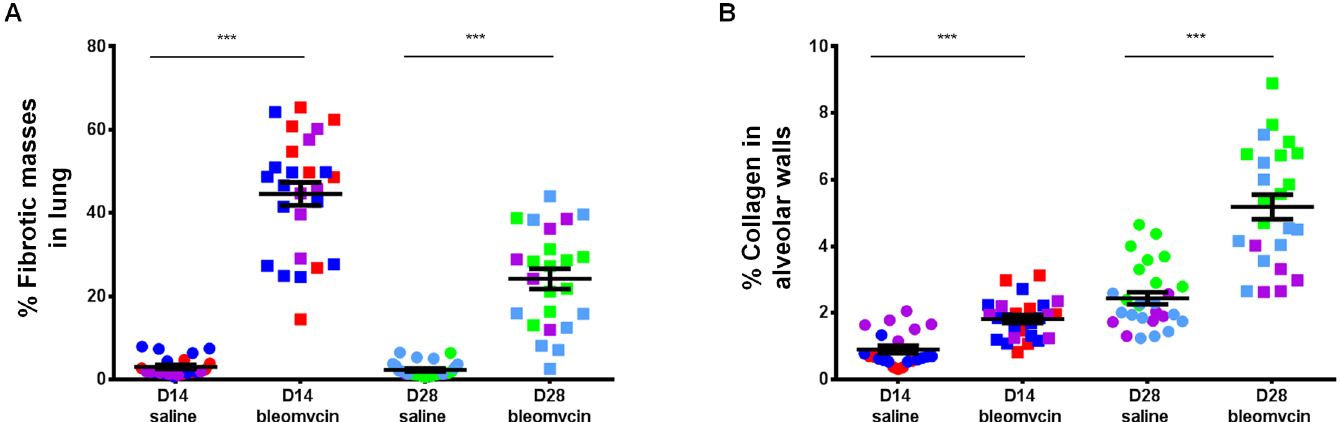
Fig 3. Inter study reproducibility of the quantification method. Automated image analysis was applied to five independent studies, performed over 2 years (3 independent studies for each time point: D14 and D28). A : percentage of fibrotic masses per lung (excluding bronchi for normalization), B : percentage of alveolar collagen deposition. Mean with +/- SEM, Mann-Whitney statistical test. Each dot represents an individual animal and color represents independent studies. Study 2: red, study 3: purple, study 4: dark blue, study 5: green, and study 6: light blue.